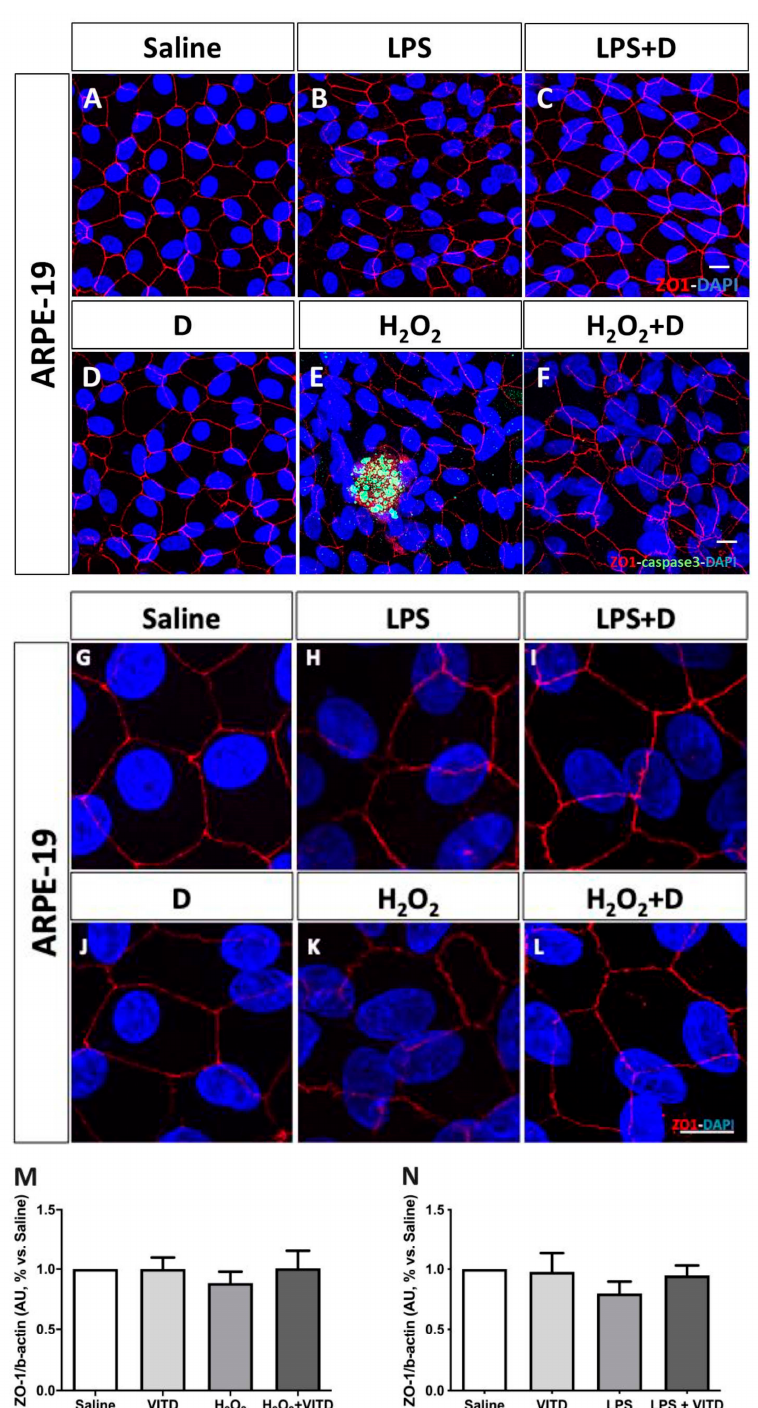
Figure 4. Integrity of ARPE-19 cells evaluated by zonula occludens-1 (ZO-1) (red) and caspase-3 (green) immunofluorescence. VITD (1 nM, 1 h; ( D )) did not a ff ect ZO-1 structure compared to saline ( A , G ). Lipopolysaccharide (LPS) ( B , H ) and H 2 O 2 ( E , K ) addition damaged tight junctions and concomitant incubation with VITD (1 nM, 1 h; ( C , I ) and ( F , L )) restored the altered structure. ( G–L ) show the apical junction in higher magnification. Caspase-3 was highly observed in the H 2 O 2 group ( E ) compared to saline ( A ) and VITD ( D ). VITD addition showed restoration, and caspase-3 activation was absent ( F ). Nuclei were labeled with DAPI (blue). Scale bar: 20 µ m. Densitometry of ZO-1 expression in ARPE-19 cells under oxidative stress ( M ) and inflammatory ( N ) conditions. Although a tendency to reduce the ZO-1 expression was observed, no statistical di ff erences were found. VITD restored values similar to saline group. n =